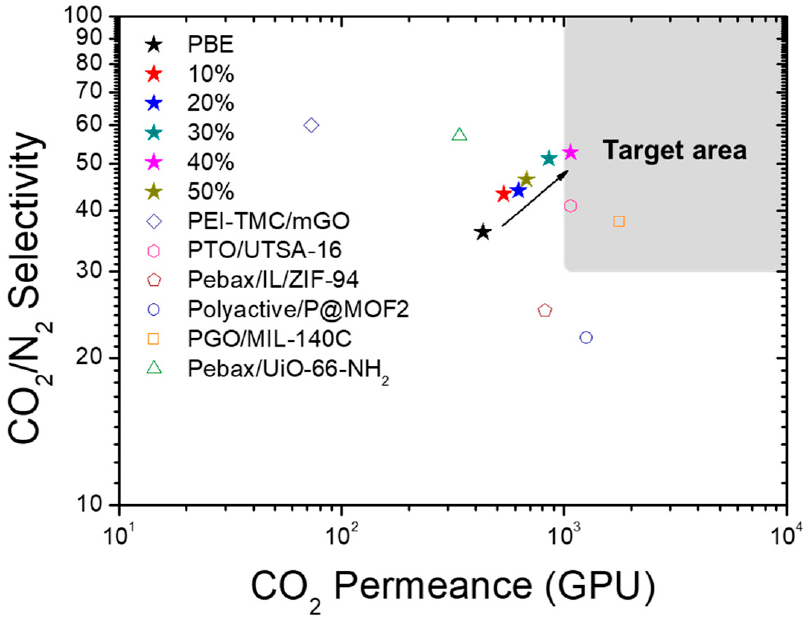
Figure 6. CO 2 permeance versus CO 2 /N 2 selectivity for PBE and PBE/MOF-808 membranes and other TFC-MMMs reported in the literature (details in Table 1).